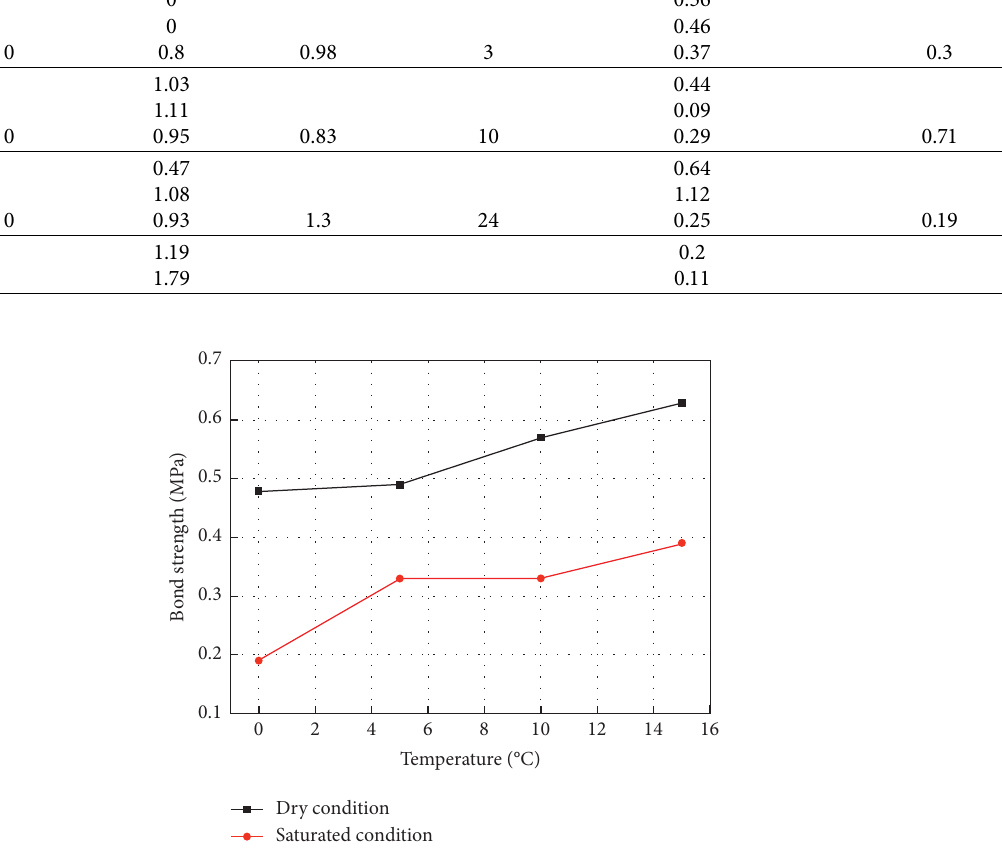
Figure 9: Relationship between temperature and bond strength. Table 4: Saturation conditions.